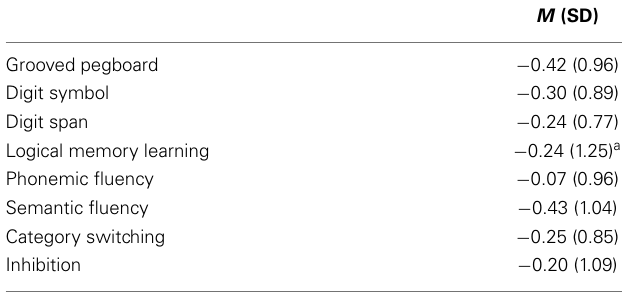
Table 2 | Neuropsychological performance in participants with schizophrenia and superior intellectual abilities